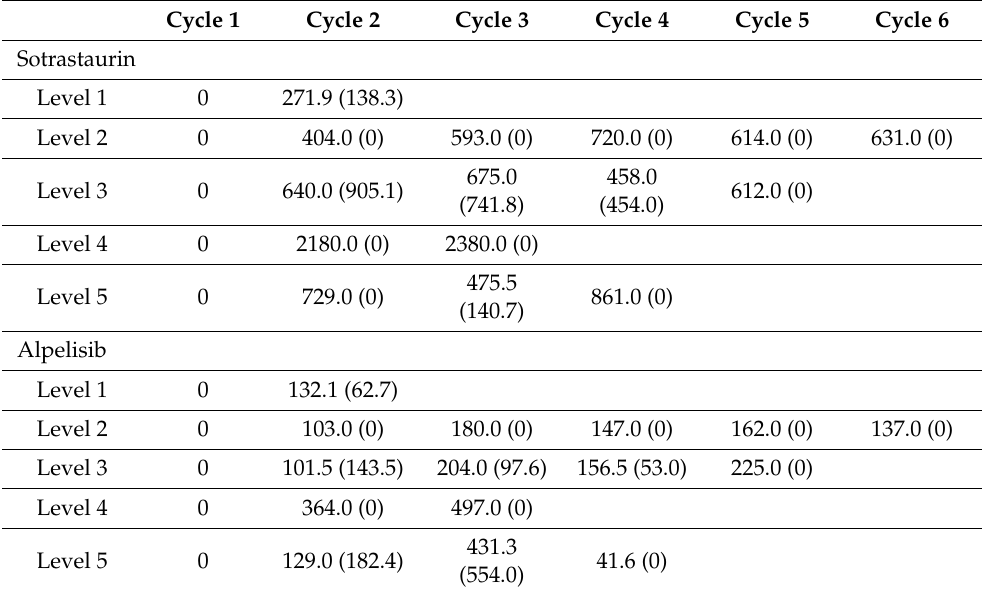
Figure 2. Plasma concentrations of sotrastaurin, AEE800, and alpelisib over time. Mean plasma concentration at Cycle 1 Day 1 (0, 0.5, 1, 2, 4, 6, 8, 24 h post-dose) and Cycle 1 Day 8 (0, 0.5, 1, 2, 34, 6, 8 h post-dose) is graphed by dose level. Error bars represent standard deviation (SD). ( a ) Sotrastaurin concentration (ng/mL) on Cycle 1 Day 1. ( b ) Sotrastaurin concentration (ng/mL) on Cycle 1 Day 8, ( c ) AEE800 (ng/mL) concentration on Cycle 1 Day 1. ( d ) AEE900 (ng/mL) concentration on Cycle 1 Day 8. ( e ) Alpelisib (ng/mL) concentration on Cycle 1 Day 1. ( f ) Alpelisib (ng/mL) concentration on Cycle 1 Day 8. Table 5. Mean pre-dose plasma concentration over time, ng/mL (SD)